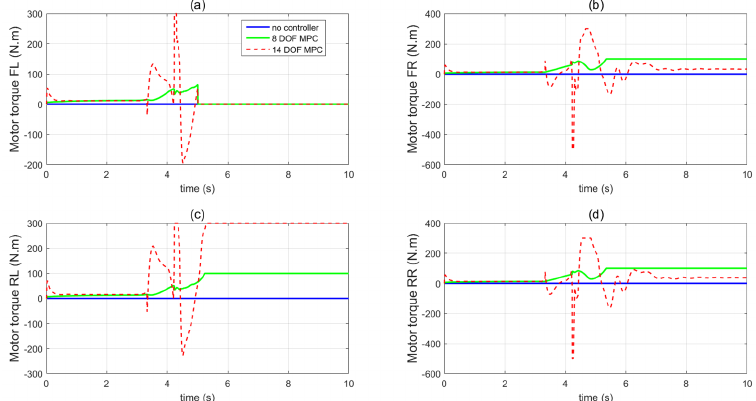
Figure 20. Vehicle motor control inputs in the third set of simulations ( a ) front left wheel, ( b ) front right wheel, ( c ) rear left wheel, ( d ) rear right wheel. 6. Conclusions This study first proposes a comprehensive 14 DOF vehicle dynamics model to de- scribe the vehicle dynamics performance after a tyre blow-out. Then, based on the pro- posed 14 DOF model, a non-linear coordinate control framework based on MPC is pro- posed. The simulation results can be summarised as follows: (1) The proposed 14 DOF vehicle dynamics model can successfully describe the effect of the changed tyre vertical stiffness, cornering stiffness and rolling resistance after a tyre blow-out on the vehicle dynamics performance.